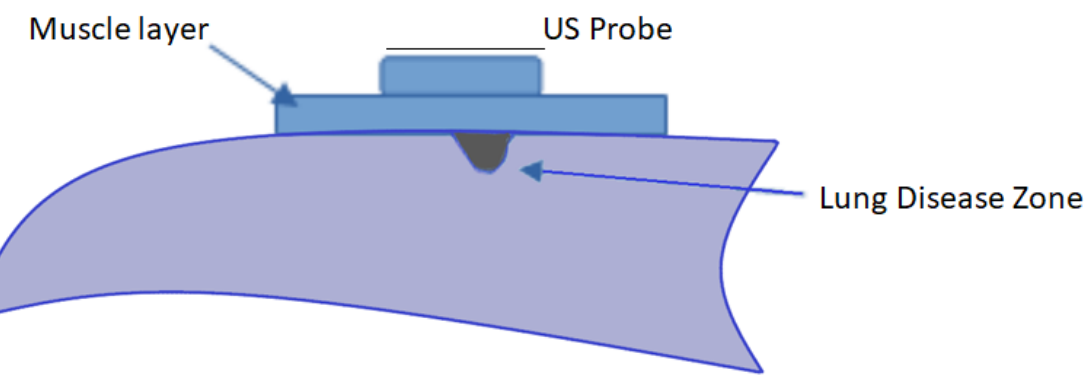
Figure 3. Lung Model Domain. There is a small ellipsoid grey zone of the lung tissue represented as the “lung disease zone” (LDZ).